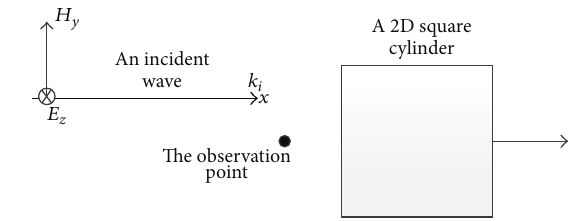
Figure 11: A plane wave normally incident on a moving conducting square cylinder.